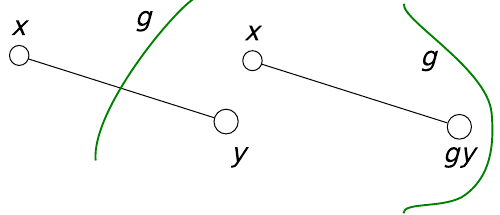
FIG. 13. When the g domain wall is pulled off of this edge, it is revealed to be an edge from x → gy . Note the similarity with the Hamiltonian coupling procedure in Appendix C.